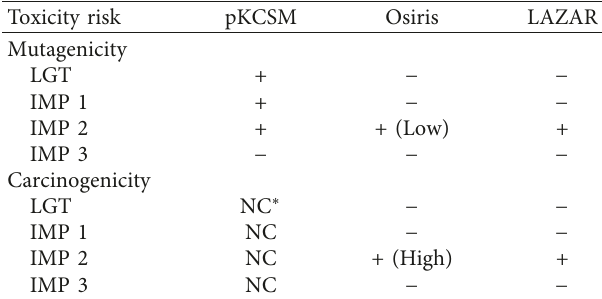
Table 5: Results of potential risk to cause toxicity for linagliptin and impurities 1 to